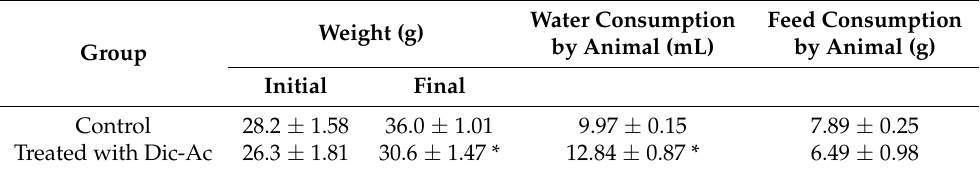
Table 2. Weight evolution and water/feed consumption of the control and treated groups with Dic-Ac in the acute toxicity experiment (2000 mg kg − 1